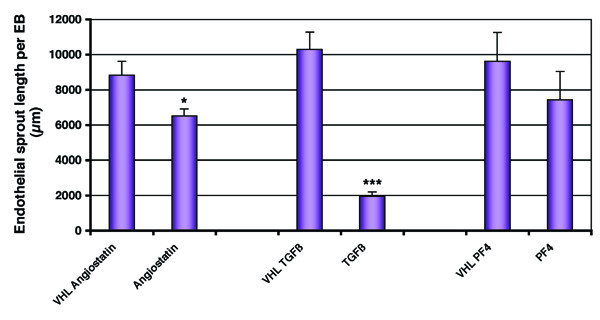
Quantitative analysis of endothelial sprouting in response to angiogenesis inhibitors. For inhibition studies of EB endothelial sprouting, VEGF (50 ng/ml) and FGF2 (100 ng/ml) were added at day 0 and at day 6 as indicated in the Methods. At day 6, EBs were also treated by the indicated angiogenesis inhibitors or by their respective vehicle (VHL). Analysis of the mean total sprout length of angiogenic EBs was performed at day 11 on 39, 25, 26, 18, 55 and 76 EBs treated with VHL TGFβ, 10 ng/ml TGFβ, VHL PF4, 2.5 μg/ml PF4, VHL angiostatin and 2.5 μg/ml angiostatin, respectively. In each condition, data represent the mean values ± SE from one out of two differentiation experiments performed in collagen gel with CJ7 ES cells. * p < 0.05, *** p < 0.001; significantly different from respective control values by unpaired Student's t test.